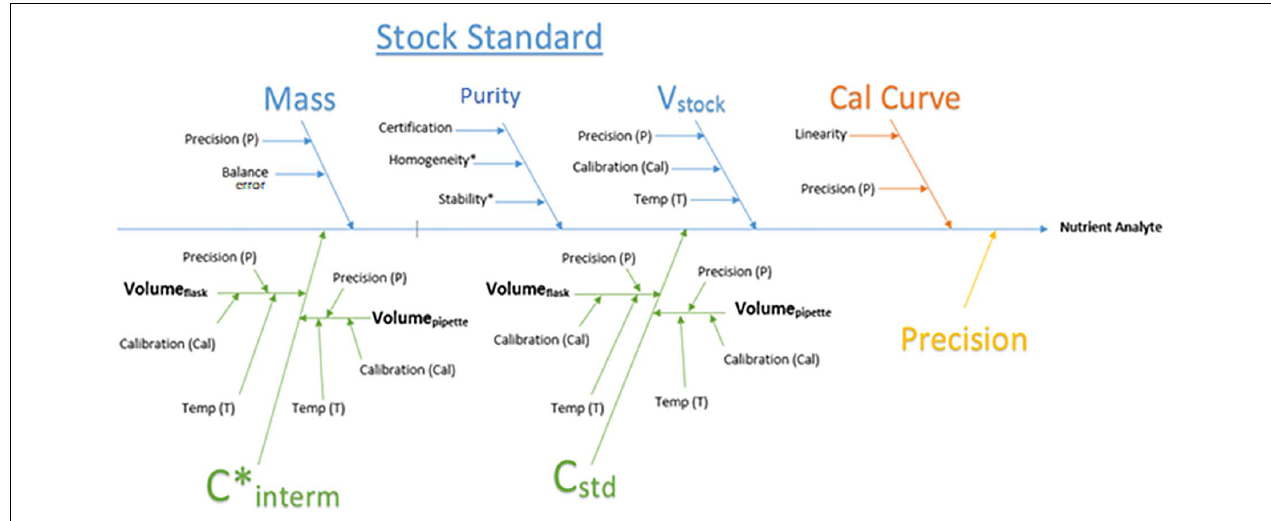
FIGURE 4 | Process flowchart for the calculation of measurement uncertainty which incorporates the error from each section cumulative to the final result. Purity = Salt purity, V stock = stock volume, Cal curve = calibration curve, C* interm = concentration of intermediate, C std = concentration of standards.